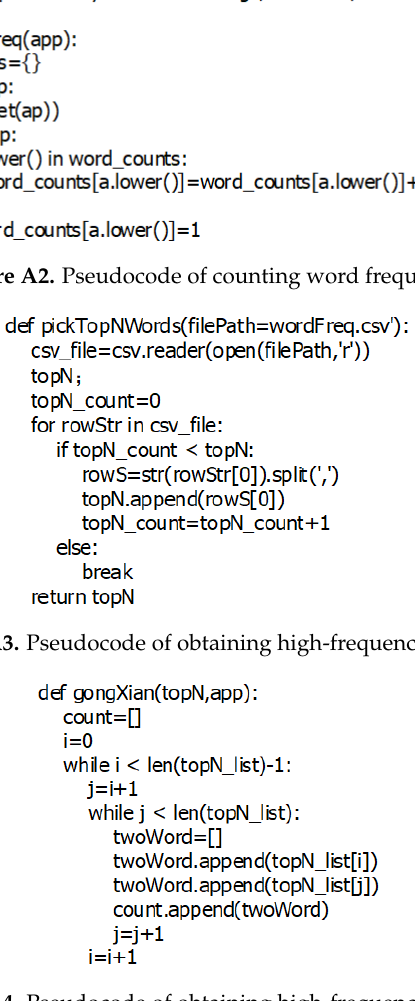
Figure A4. Pseudocode of obtaining high-frequency words.